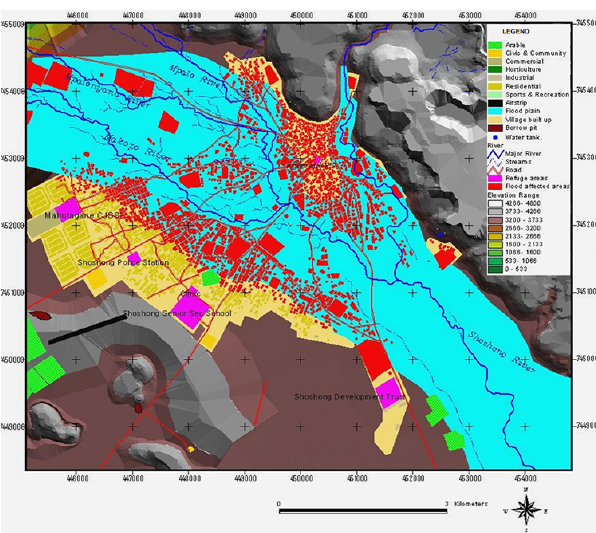
Figure 7. Probable paths followed by the Okavango, Cuando and Zambezi rivers when they were still major tributaries of the palaeo- Limpopo River (adapted from Moore and Larkin, 2001).